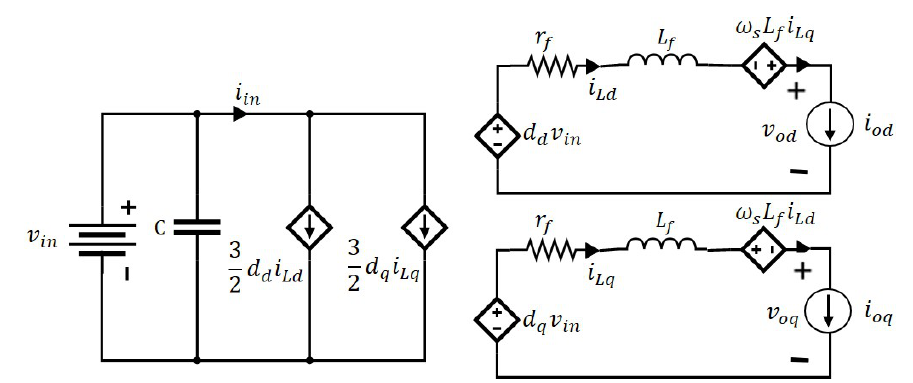
Figure 7. Equivalent circuit model of grid-forming converter [89]. The impedance transfer functions are analyzed and plotted in Matlab using the parameters in Table 2. The bode plots for the input and output impedances of the inverters are shown in Figures 9 and 10, respectively. Figure 9 shows that the input impedance is non- passive in the region between the fundamental frequency and the controller bandwidth which can cause any load disturbance to affect the DC-link. This effect is revealed by the simulation results in Figure 11 where a sudden load increase from 0.75 p.u. to 0.9 p.u. creates oscillations in the DC-link voltage (that, in turn, affects the output modulation). Hence, the inverter does not sufficiently isolate the DC source from the AC